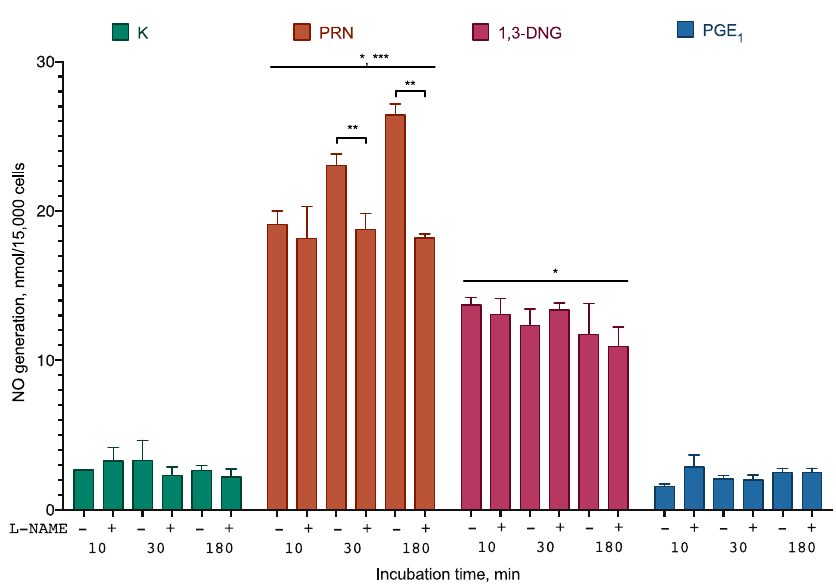
Figure 3. NO generation from Prostanit and its analogs by differentiated smooth muscle cells. The cells were treated with 35 µM of Prostanit or 90 µM PGE 1 or 1,3-DNG with or without 100 µM of the NO synthase inhibitor L-NAME (L-N G -Nitro arginine methyl ester). PRN, Prostanit; 1,3-DNG, 1,3-dinitroglycerol; PGE 1 , prostaglandin E 1 . Griess assay data, mean ± SD; *, a statistically significant difference from the control (K); **, a statistically significant difference from the samples with L-NAME; ***, a statistically significant difference from 1,3-DNG; p < 0.05 in ANOVA with Tukey’s post- test.